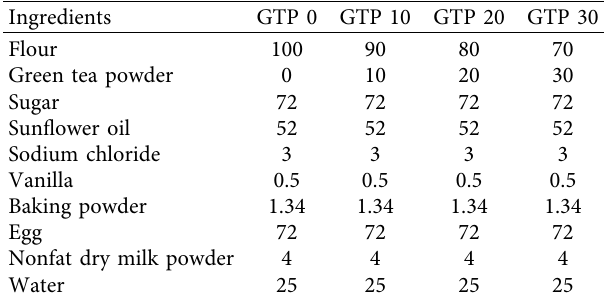
Table 1: The sponge cake formulation with various percentages of flour replacement with green tea powder (GTP).